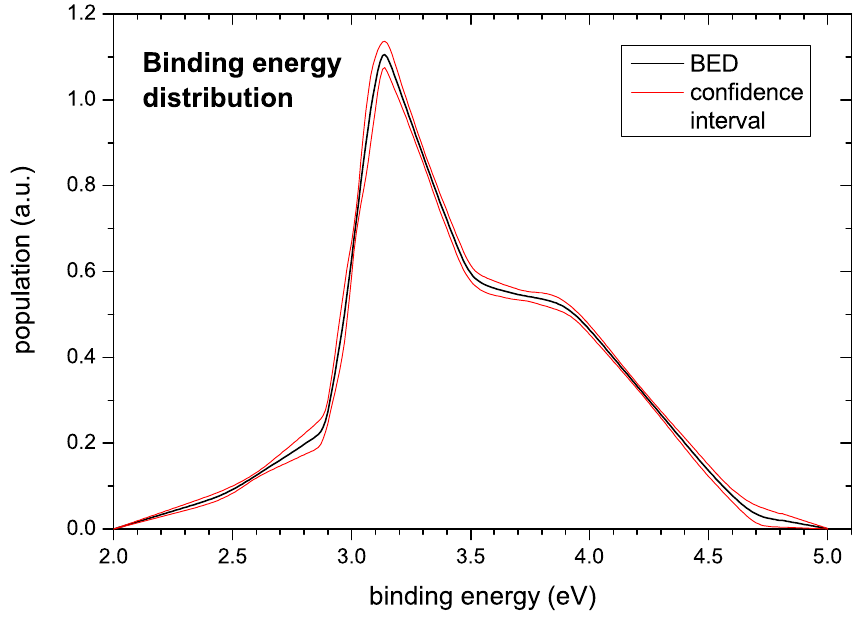
Figure 10. Simulated binding energy distribution (population density) calculated using ν = 1 × 10 16 1/s. The shown confidence interval is calculated from the experimental data using the model explained in Section 3. For a given value of ν the BED is tightly constrained by the experimental